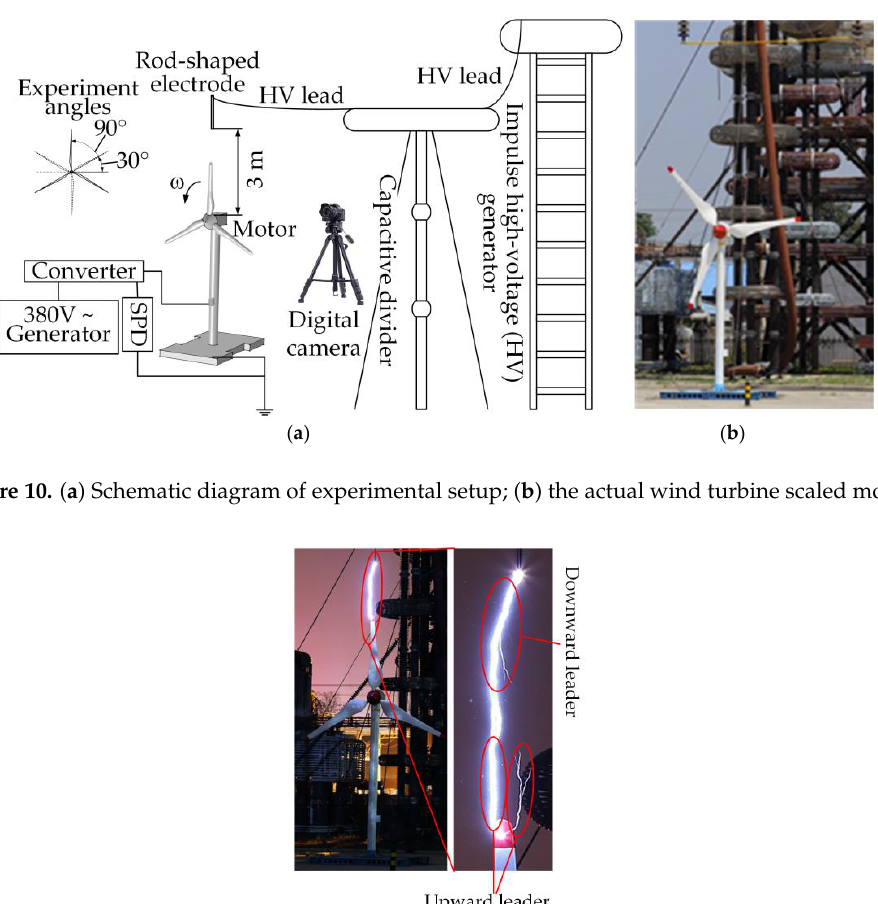
Figure 10. ( a ) Schematic diagram of experimental setup; ( b ) the actual wind turbine scaled model.